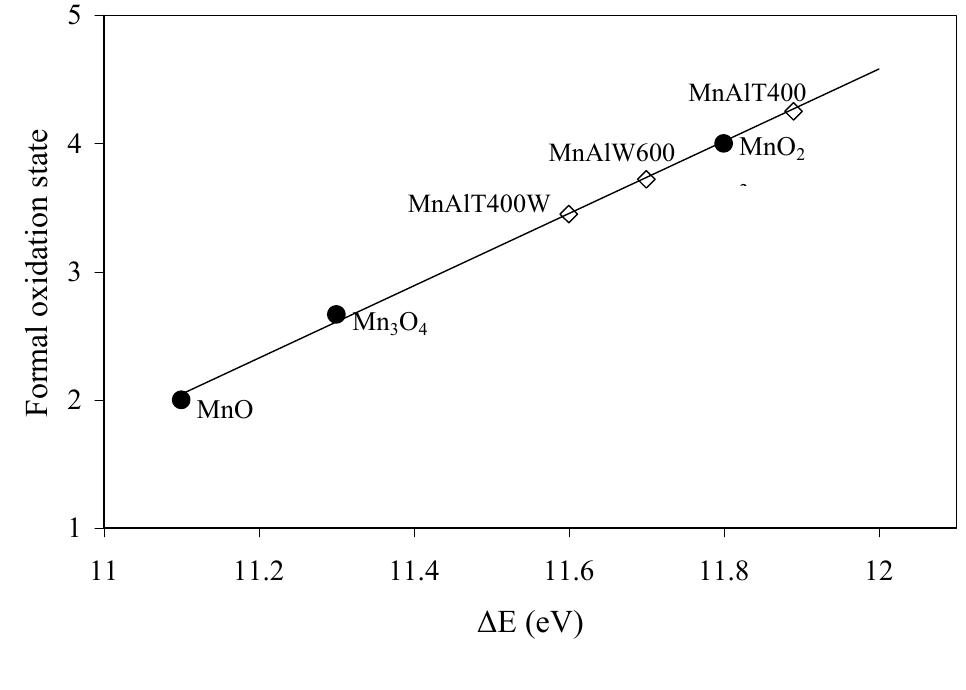
Figure 9. Formal oxidation state of manganese as a function of the difference between the binding energy of the Mn 2p 3/2 and Mn 2p 1/2 XPS